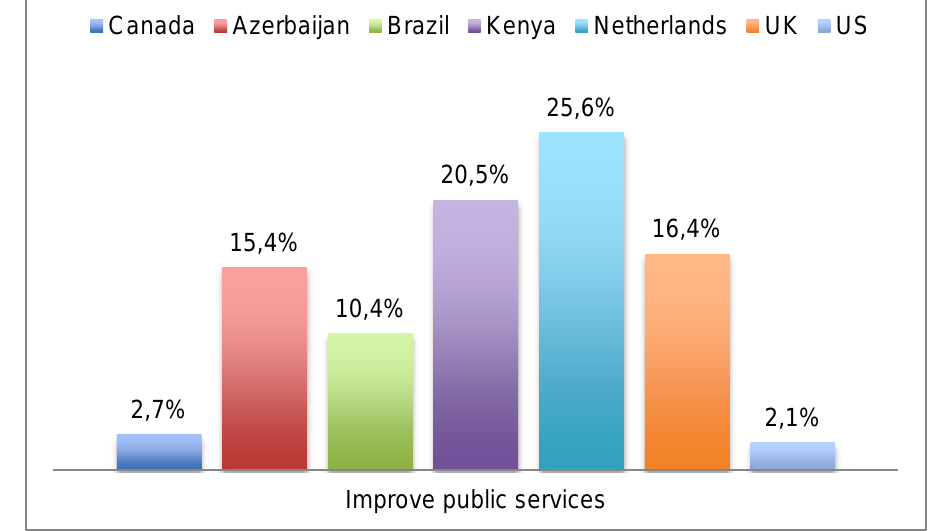
Figure 4: Salience of the code “Improve public services” by country Action